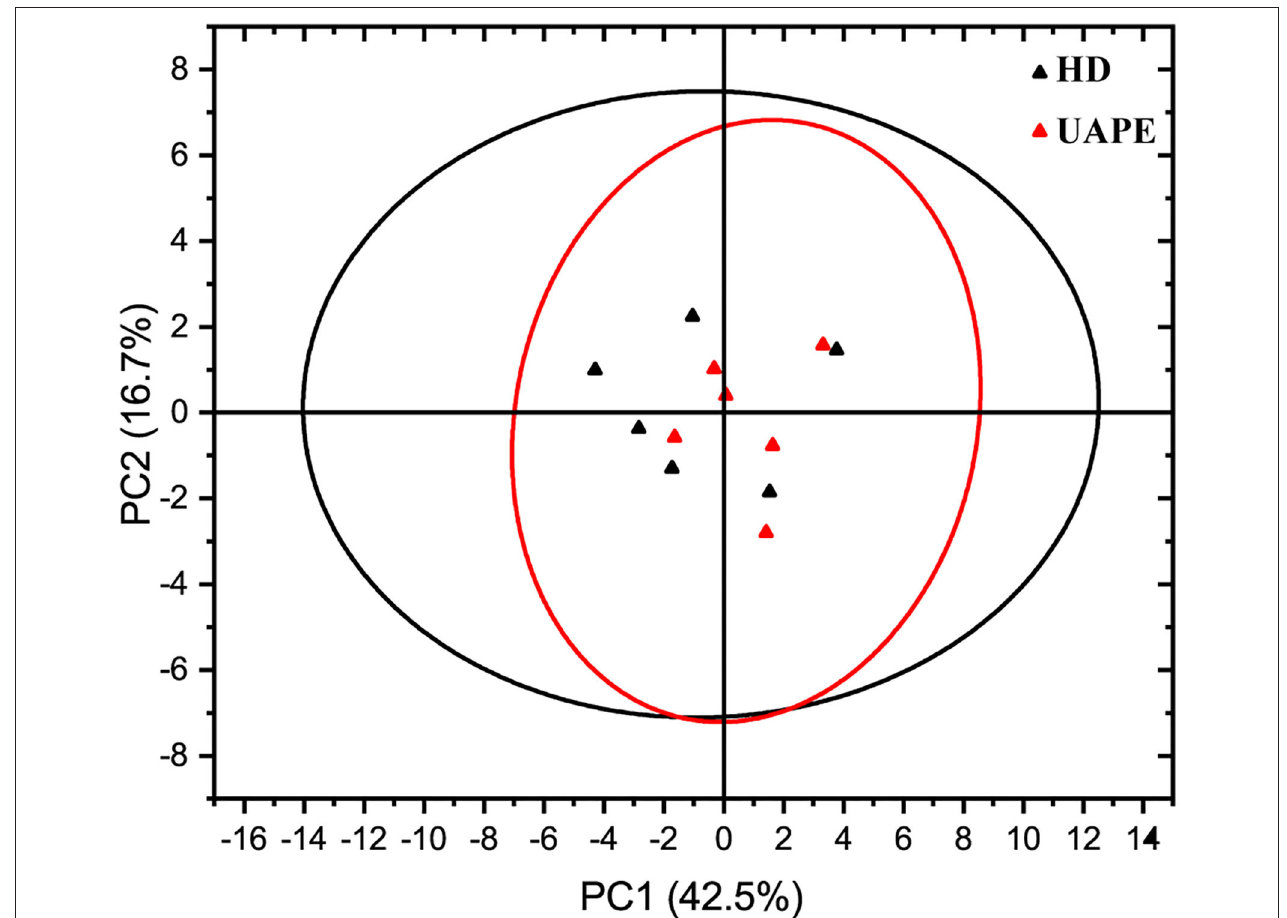
FIGURE 9 | Principal component analysis of electronic nose data from TCEO by the UAPE and HD